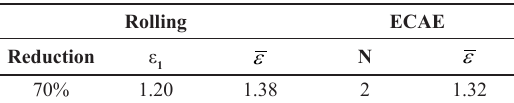
Table 2. Equivalent strain measures, ε .